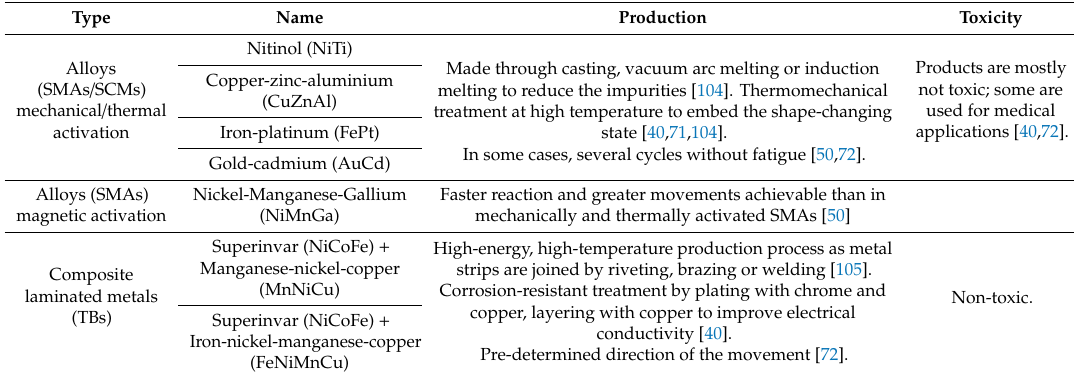
Table 4. Qualitative information on the production of AM alloys and metals.